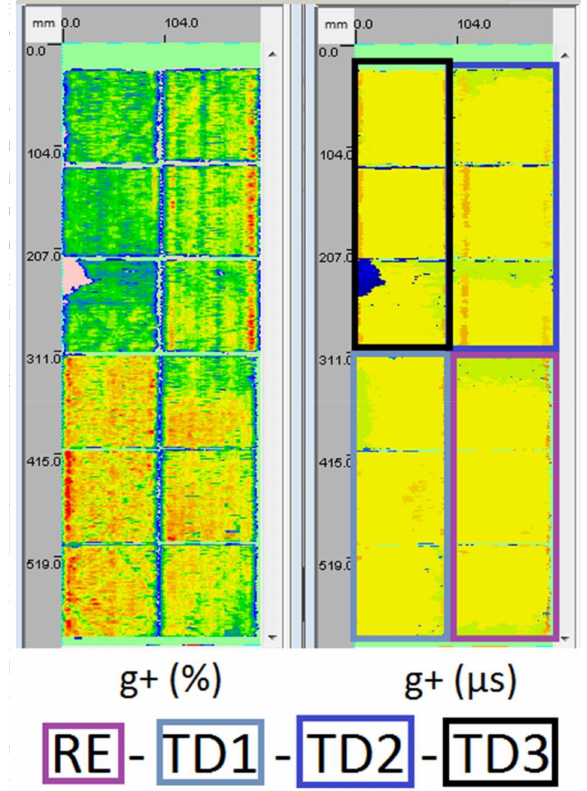
Figure 5. Ultrasonic g+ gate amplitude and time of flight results for reference samples (RE) and thermally treated samples